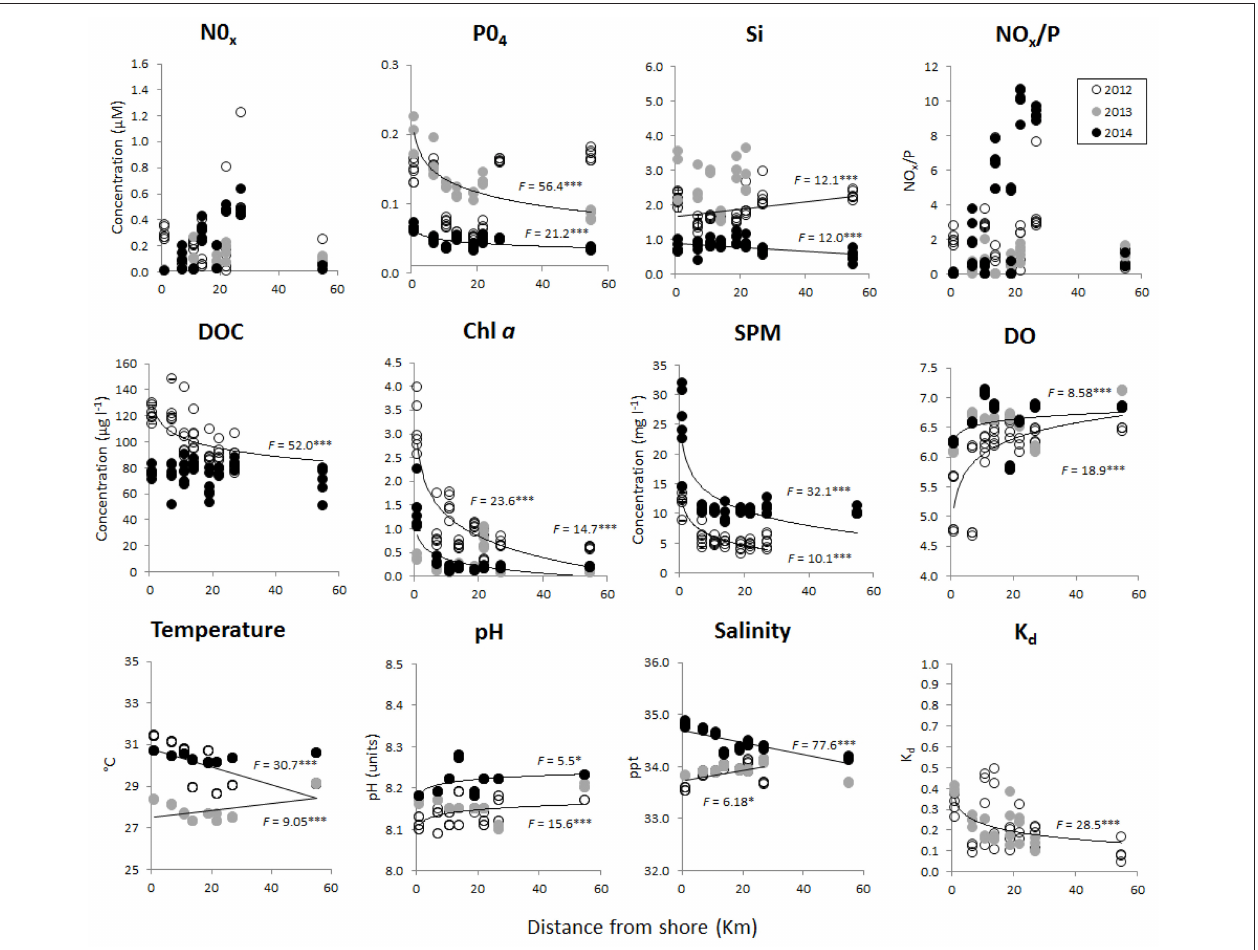
FIGURE 2 | Environmental variables measured at each site in 2012 (white), 2013 (gray), and 2014 (black). Sites are represented by distance from shore (km) on the x-axis. Regressions are indicated for variables that showed a significant increase or decrease with distance, after testing first for differences across years and pooling years that were not significantly different from each other (PERMANOVA, results from Table S1). Full results from regression analyses equations and R 2 values are shown in Table 1 . Asterisks indicate level of significance (*** < 0.001 and * < 0.5).